Question: Author a descriptive caption for the visualization shown.
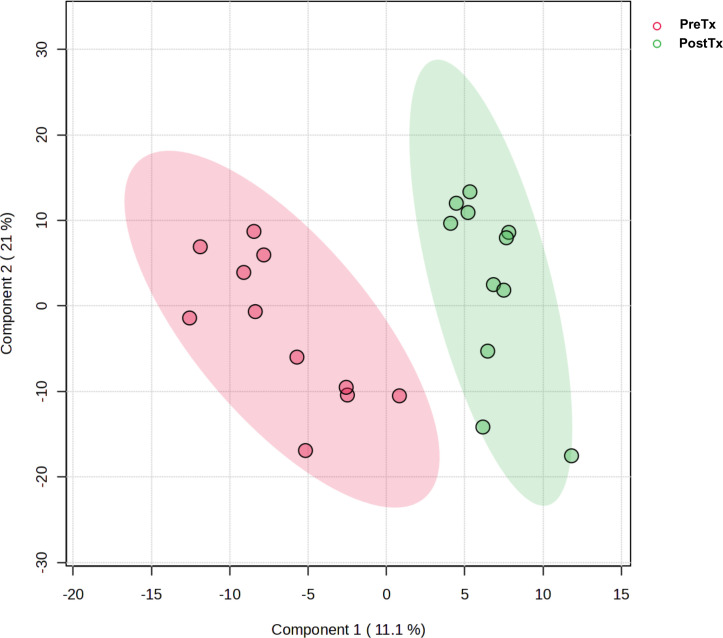
Answer: Partial least squares-discriminant analysis (PLS-DA) plot of differential metabolites in patients with congenital hypothyroidism pre- and post- the onset of treatment. The ellipse represents the 95% confidence interval based on Hotelling’s T2 statistics. Score plot derived from the PLS-DA model demonstrating group separation. Model robustness is indicated by R2Y = 0.9 (goodness-of-fit) and Q2 = 0.6 (predictive capacity). Q2 was cross-validated to ensure model stability. The optimal number of classification components was determined via 5-fold cross-validation (5-fold CV), with model performance evaluated based on the Q2 score.